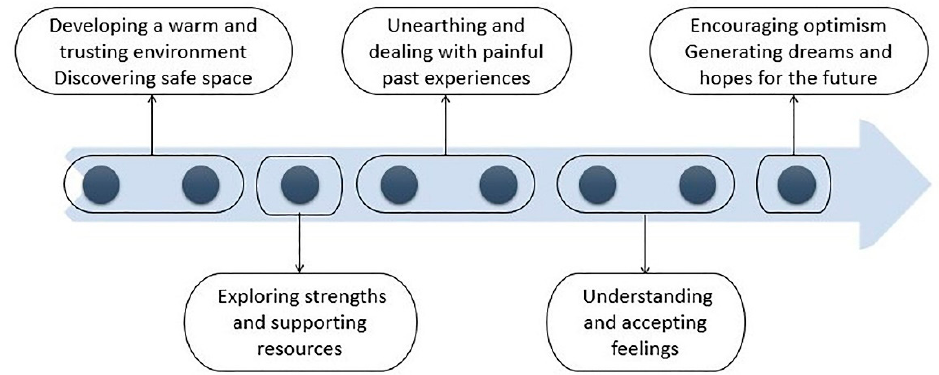
Figure 1. The therapeutic model followed in the arts therapies intervention